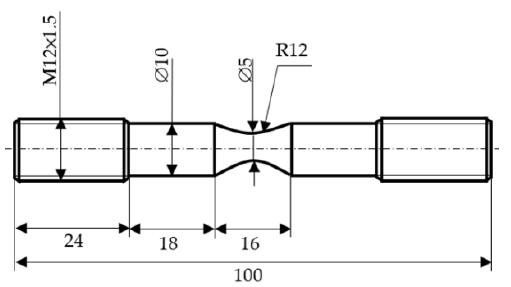
Figure 1. Schematic illustration of the geometry of tensile test specimens.